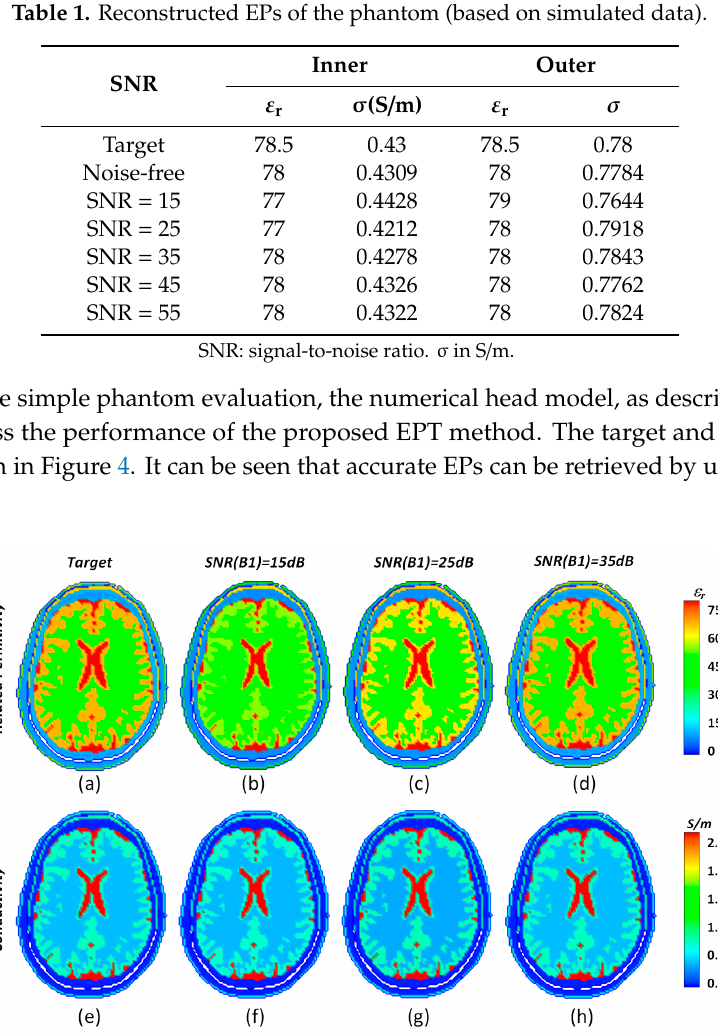
Figure 4. The target and reconstructed EP profiles under different SNR levels (15~35 dB). ( a ) and ( e ) are the target EPs. ( b ) and ( f ) are the results under SNR level is 15 dB. ( c ) and ( g ) are the results under SNR level is 25 dB. ( d ) and ( h ) are the results under SNR level is 35 dB.